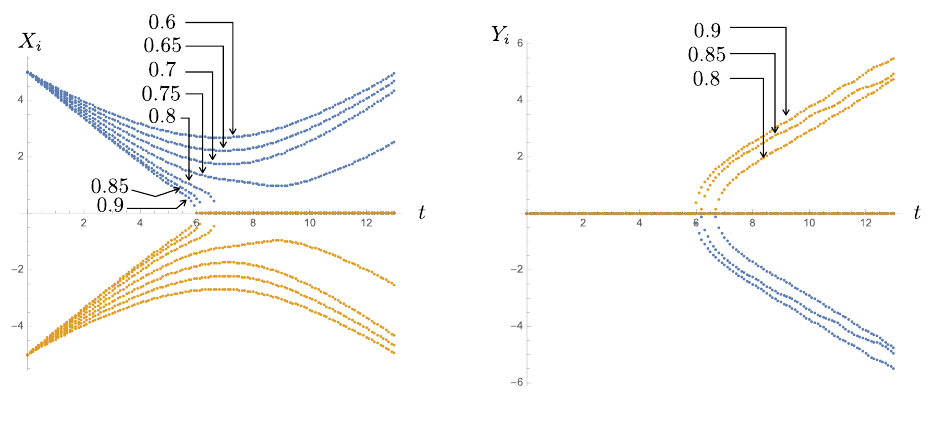
Figure 10 . The trajectories ( X i ( t ) , Y i ( t )) of the two orthogonal vortices for u =